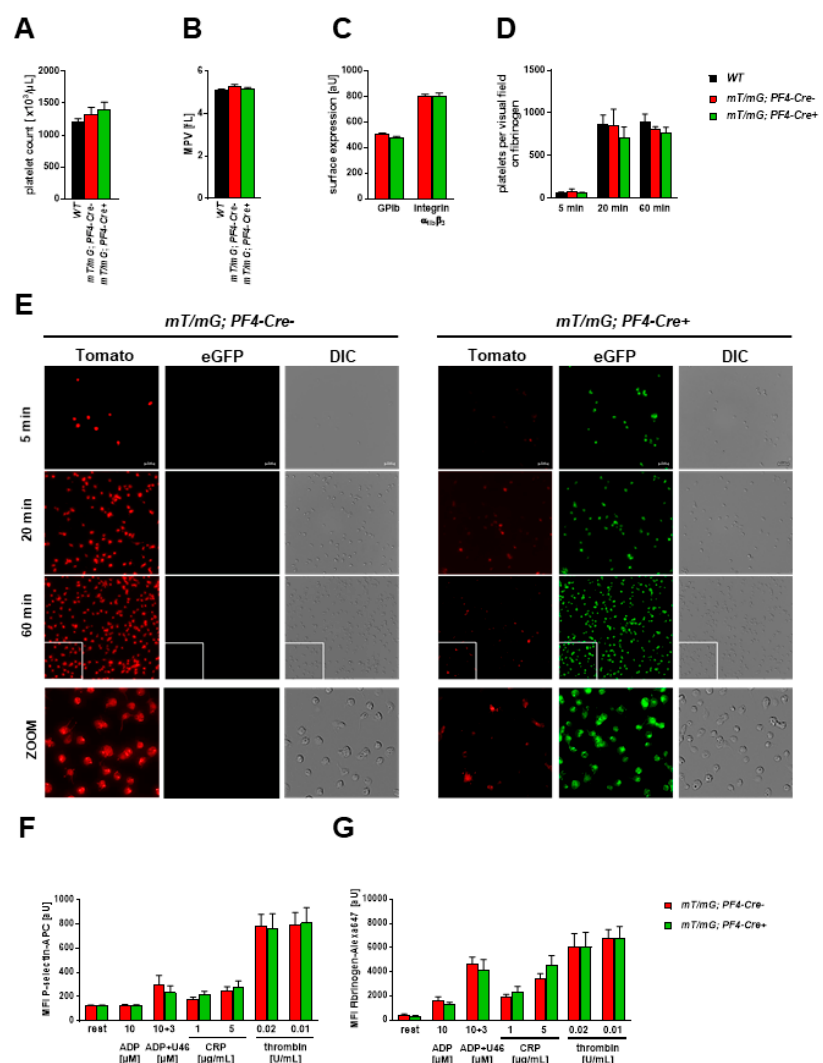
Figure 3. Unaltered platelet activation and receptor surface expression in mT/mG PF4-Cre negative and positive mice. ( A ) No differences were observed in platelet counts, ( B ) platelet size (mean platelet volume, MPV) between WT and mT/mG;PF4-Cre negative and positive mice and ( C ) in the expression of glycoprotein (GP) Ib and integrin α IIb β 3 between mT/mG;PF4-Cre negative and positive mice. GP expression was determined using DyLight649-labeled anti-mouse GPIb α and DyLight649- labeled anti-mouse integrin α IIb β 3 using flow cytometry. Statistical analysis was performed by Kruskal–Wallis test and Dunn (cid:48) s post hoc test ( A , B ) and two-tailed Student (cid:48) s t-test ( C ). Bar graphs depict mean values ± SEM, n = 6–8. ( D , E ) Isolated platelets were allowed to adhere to fibrinogen [100 µ g/mL] for indicated time points and fixed with PFA. Statistical analysis was performed by two-Way ANOVA Tukey (cid:48) s post hoc test. Bar graphs depict mean values ± SEM, n = 3–4. ( D ) The number of adherent platelets per visual field was determined. ( E ) Representative images showing platelet adhesion and platelet morphology of mT and mG fluorescent platelets, n = 3–4, scale bar 10 µ m. ( F , G ) Platelet degranulation (P-selectin exposure) and fibrinogen binding (marker for integrin activation) following activation with indicated agonists was determined in washed whole blood using flow cytometry. ( F ) P-selectin externalization was analyzed with an anti-human/mouse CD62P- APC antibody, n = 6–7. ( G ) Fibrinogen binding was determined using fibrinogen-Alexa Fluor™ 647, n = 5–6. Statistical analysis was performed by two-tailed Student’s t -test. Bar graphs depict mean values ± SEM. CRP = collagen-related peptide, U46 = Thromboxane A2 analogue, ADP = adenosine diphosphate, DIC = differential interference